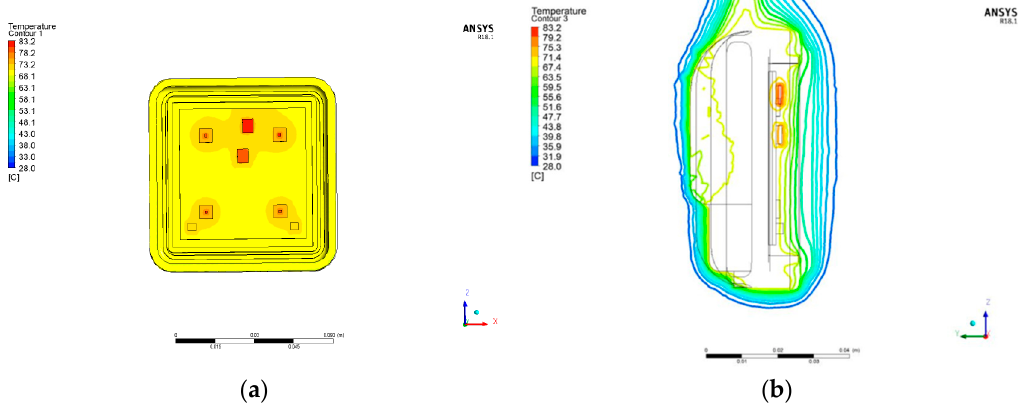
Figure 14. Simulation result of the 60 V power LED. ( a ) Temperature field of the 60 V LED. ( b ) Isotherm diagram of the 60 V power LED.